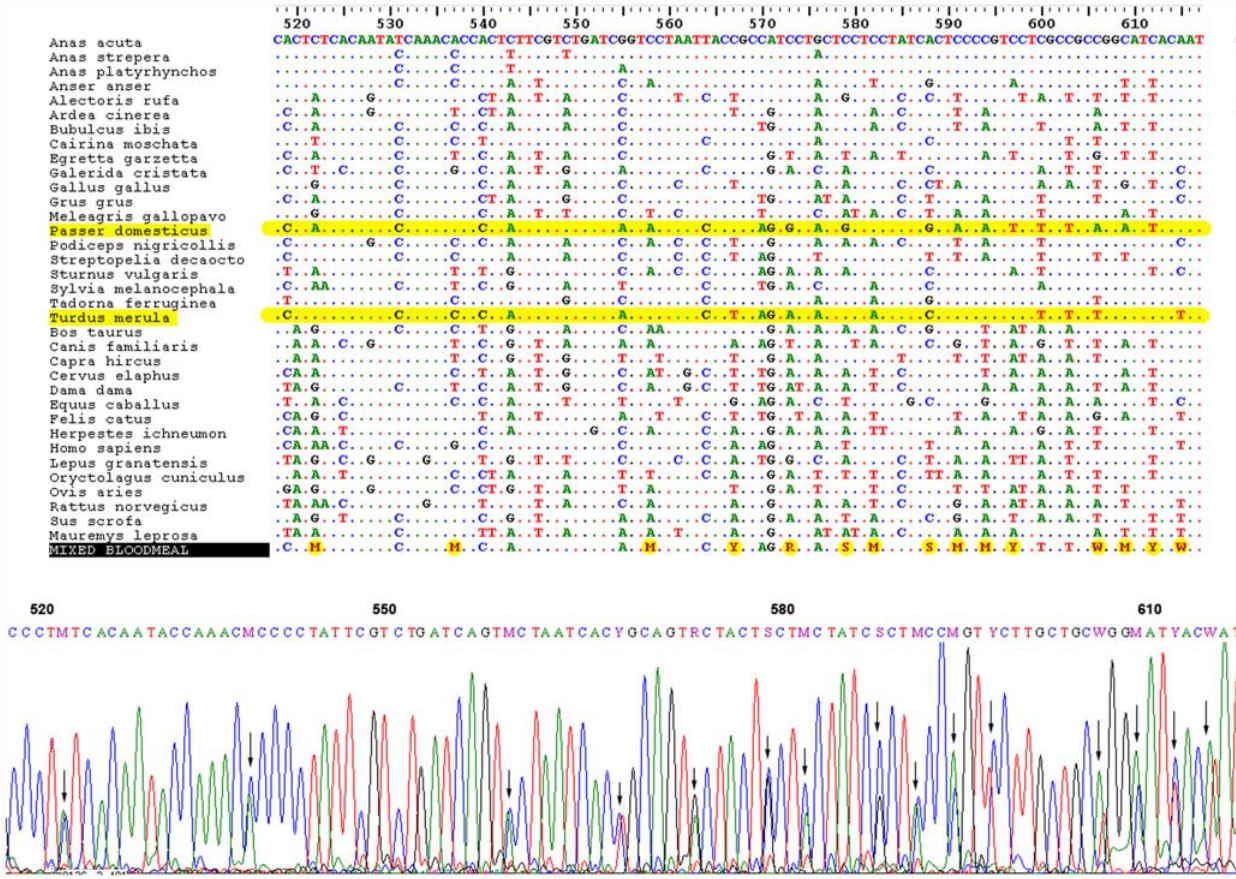
Figure 1. Identification of a mixed bloodmeal. The co-amplification of COI fragments from different hosts may generate several ambiguous nucleotide positions (in yellow and indicated by arrows). The ambiguous sequence can be subsequently compared with respect to a validated set of COI sequences from the hosts typically found in the study area. In this example, the sequencing electropherogram obtained could be the result of the simultaneous amplification of DNA from house sparrow Passer domesticus and common blackbird Turdus merula